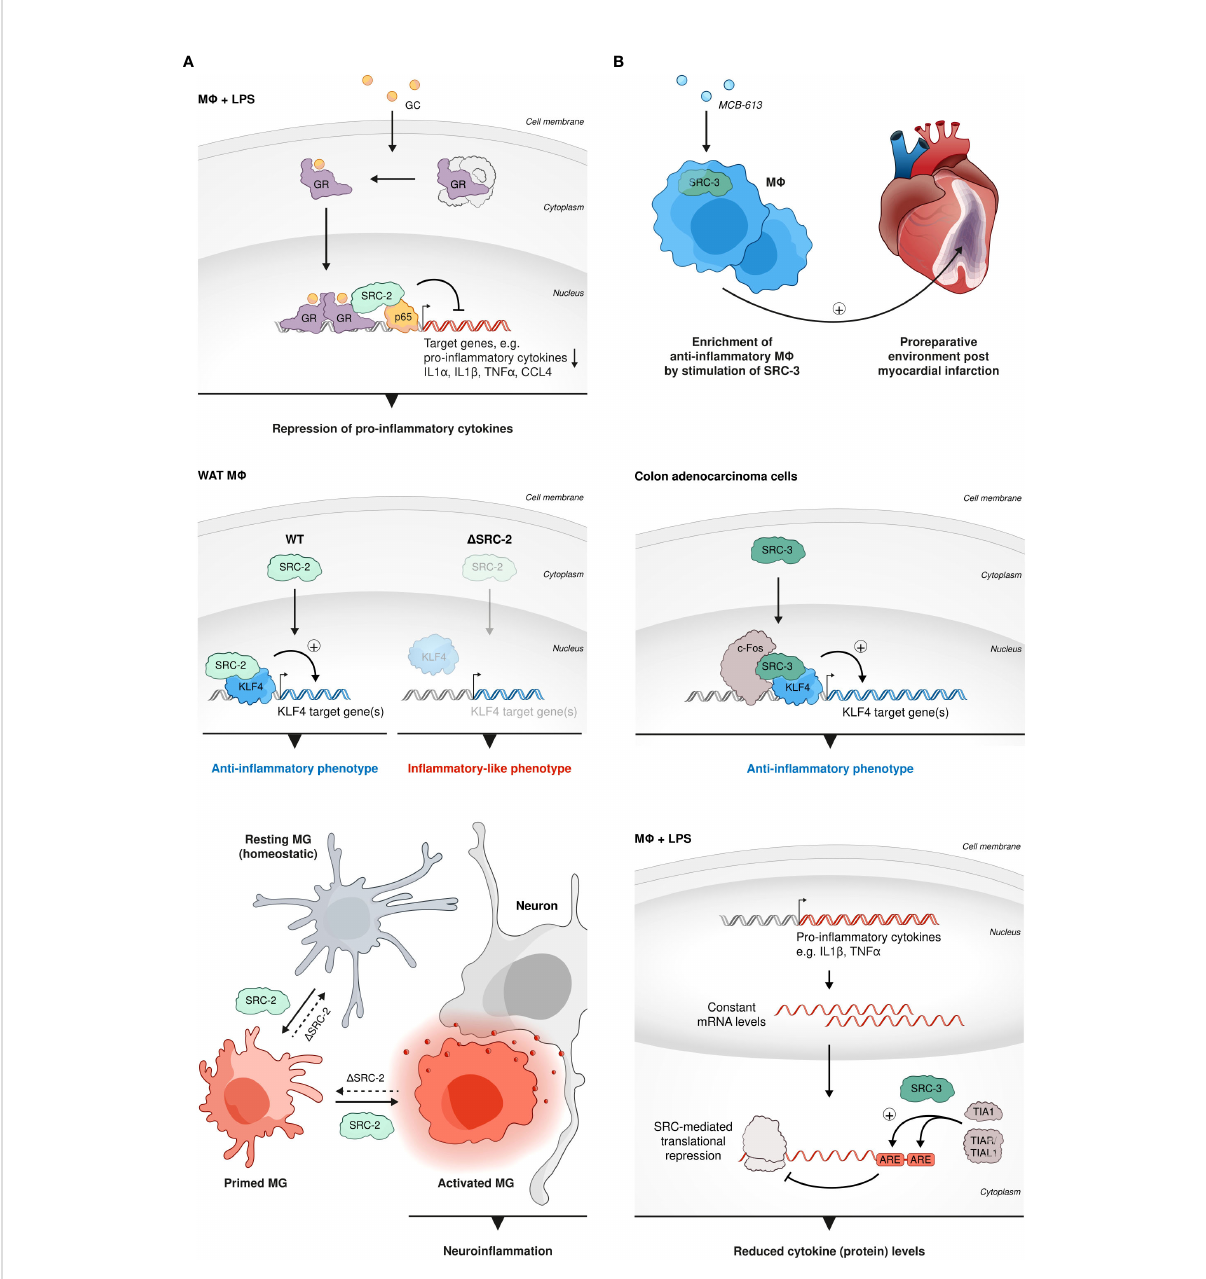
FIGURE 2 SRCs role in M F s. (A) Anti-in fl ammatory and pro-in fl ammatory roles of SRC-2 in M F s. SRC-2 participates in GC-mediated repression of pro- in fl ammatory cytokine genes: GR-mediated repression of IL1 a , IL1 b , TNF a , and CCL4 in BMM F s, following LPS stimulation, positively correlates with co- recruitment of GR and SRC-2 to NF- k B-binding sites occupied by p65 (top). SRC-2 is recruited along with KLF4 to KLF4 target genes in WAT M F s to promote the induction of anti-in fl ammatory commitment of these cells (middle left). SRC-2 KO results in attenuated KLF4 expression and activity and drives the shift of WAT-resident M F s into an in fl ammatory-like phenotype (middle right). In MG SRC-2 drives neuroin fl ammation through activation of a proin fl ammatory program which re fl ects in a homeostatic signature of MG cells and reduced EAE severity in mice with conditional SRC-2 KO in myeloid cells (bottom). (B) SRC-3 has an anti-in fl ammatory role in M F s. SRC-3 stimulation brings about enrichment of anti-in fl ammatory M F s: Anti- in fl ammatory M F s are enriched by stimulation of SRC-3 with a small molecule stimulator MCB-613 to promote the establishment and maintenance of a pro-reparative environment post MI (top). In colon adenocarcinoma cells SRC-3 interacts with c-Fos to promote KLF4-related gene expression to regulate in fl ammation (middle). SRC-3 downregulates proin fl ammatory cytokines: following LPS-stimulation SRC-3 downregulates protein levels, but not mRNA amounts, of proin fl ammatory cytokines such as TNF a and IL-1 b in M F s, which indicates translational derepression rather than GR-related transcriptional suppression